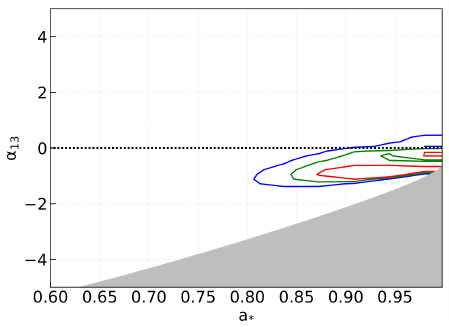
Figure 5. Constraints on the spin parameter a ∗ and the Johannsen parameter α 13 from the study in Ref. [61] of RXTE data of GX 339–4. The red, green, and blue lines indicate, respectively, the 1-, 2-, and 3- σ confidence level curves for two relevant parameters after MCMC simulations. The grayed region is ignored because those spacetimes violate the constraint in Equation